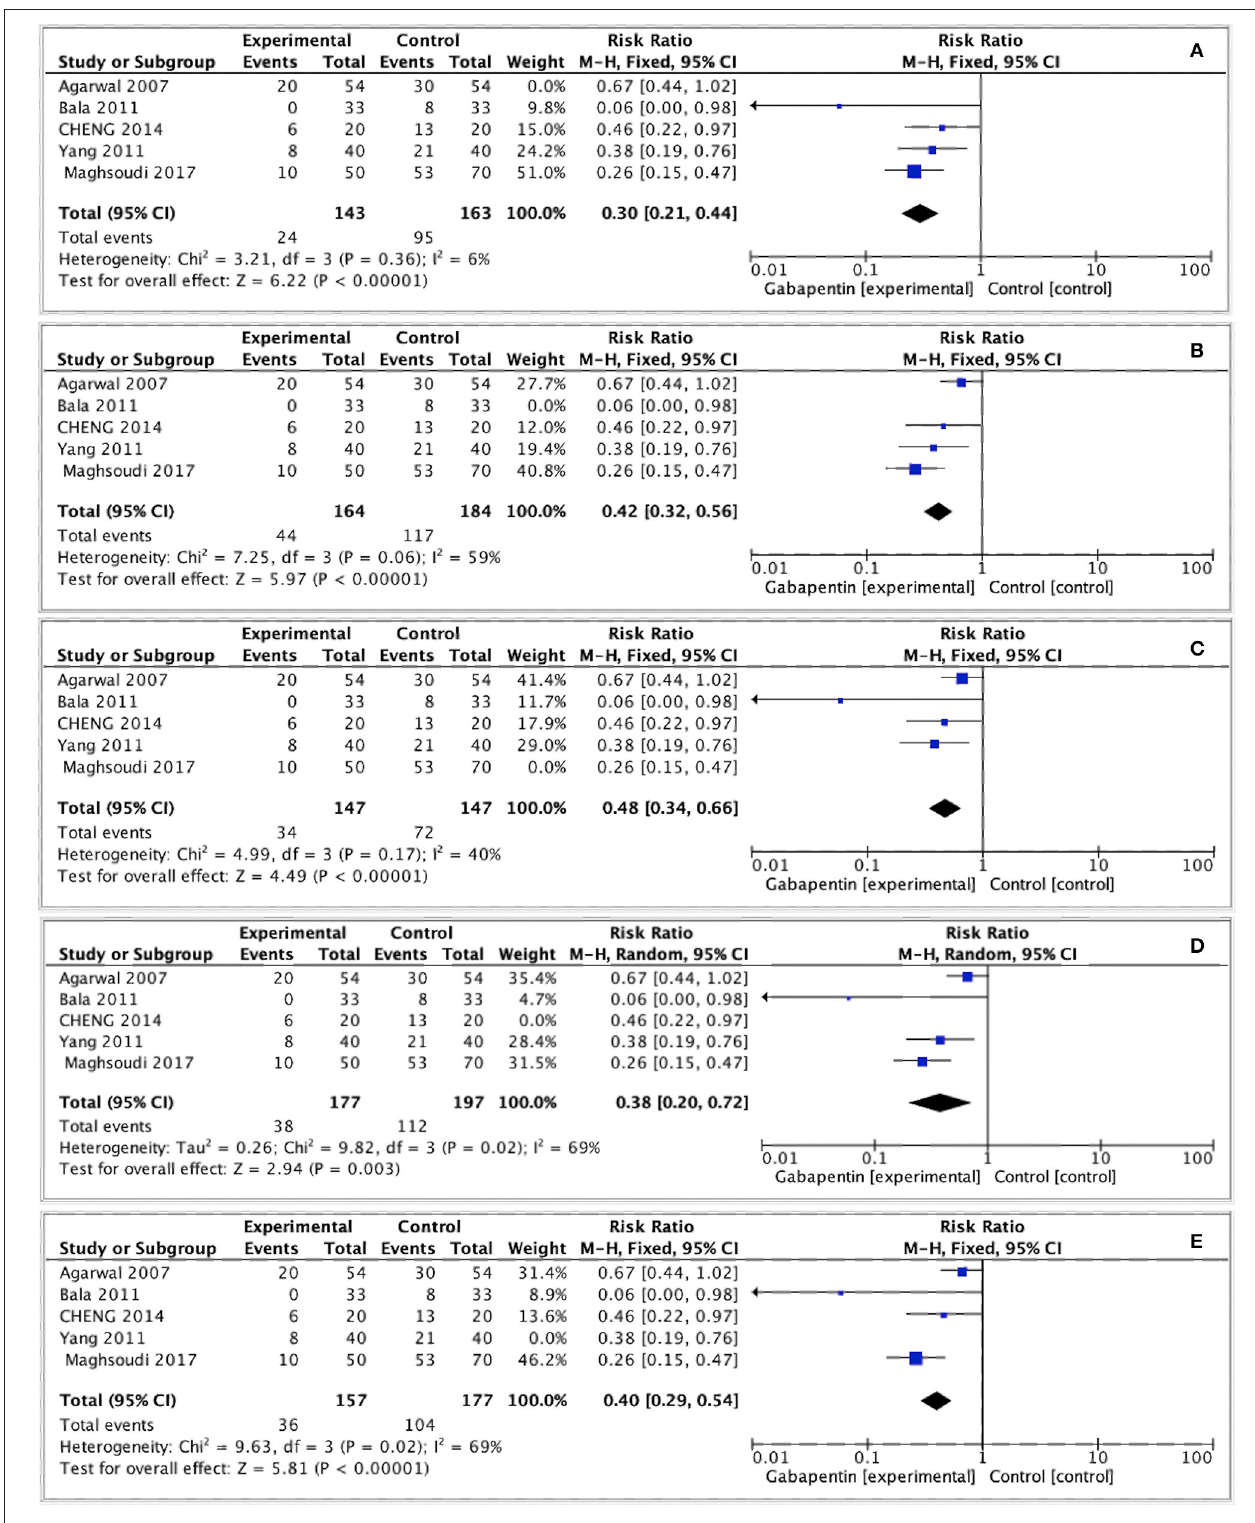
FIGURE 8 | Sensitivity analysis. (A) Sensitivity analysis by removing Agarwal’s study. (B) Sensitivity analysis by removing Bala’s study. (C) Sensitivity analysis by removing Maghsoudi’s study. (D) Sensitivity analysis by removing Yang’s study. (E) Sensitivity analysis by removing Cheng’s study.